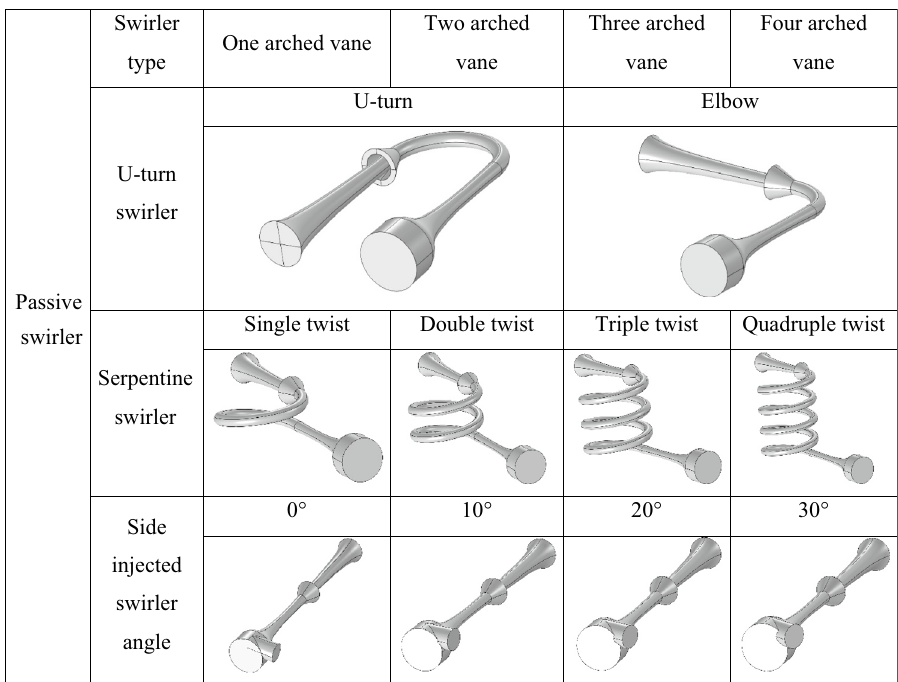
Table 2. Structure of various investigated passive